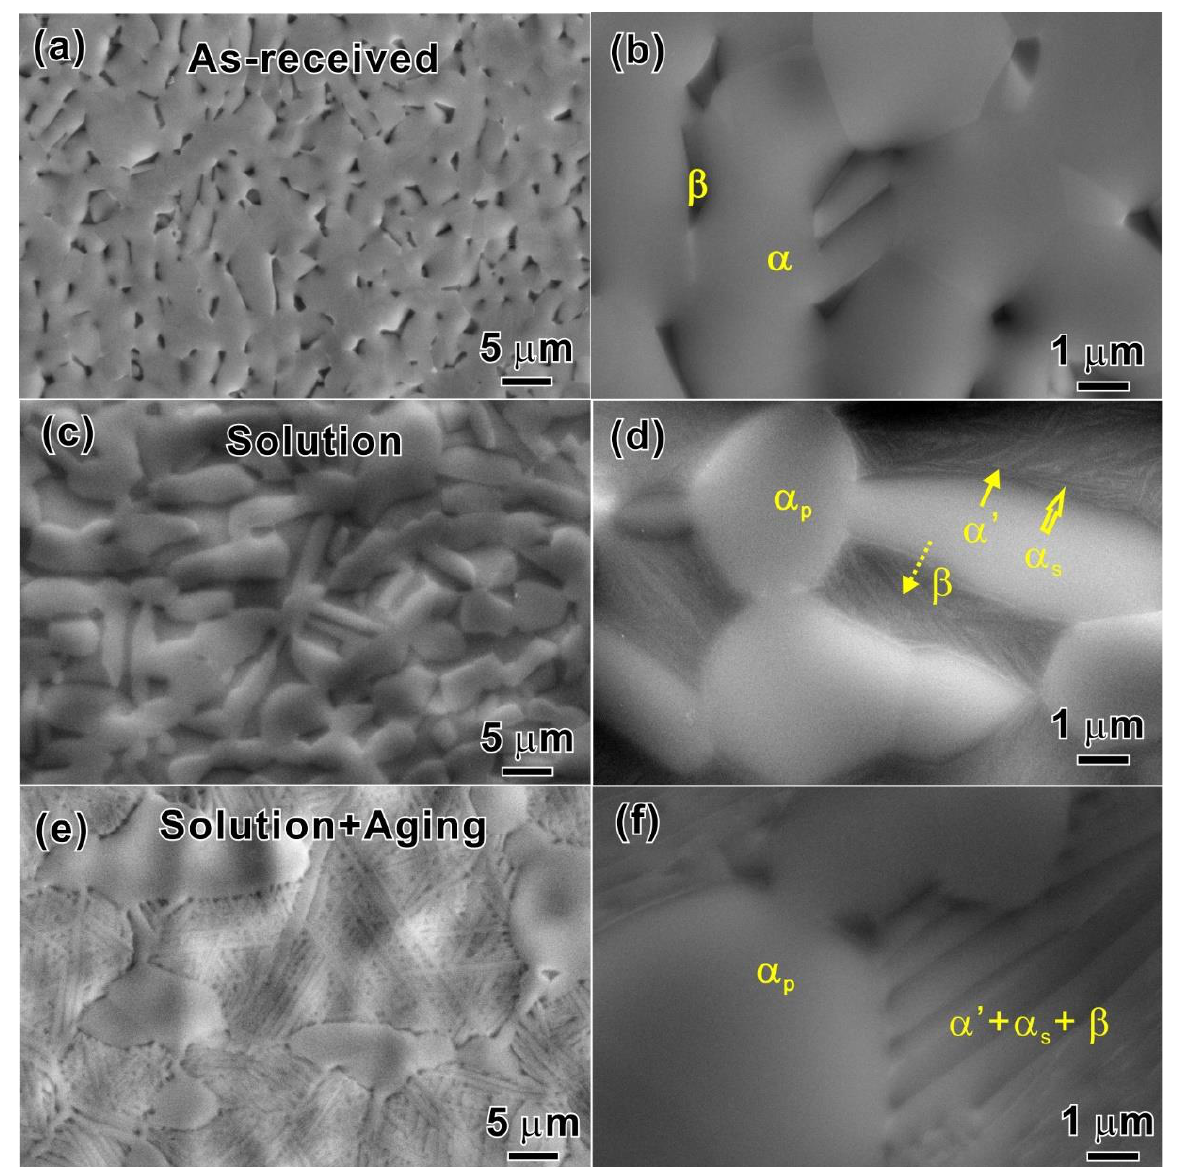
Figure 2. ( a ) As-received microstructure. ( c ) nearly equiaxed and elongated α p microstructure with the formed α′ martensite, α s and retained β phases after ST at 895 °C followed by water cooling. ( e ) bimodal microstructure after solution and aging treatment. ( b , d , f ) the magnified observations of ( a – c ), respectively.